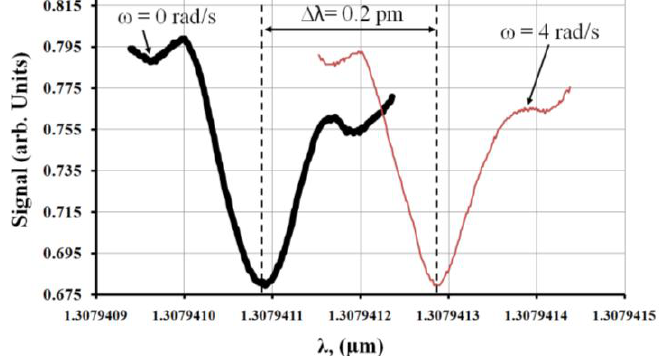
Figure 7. Transmission spectrum of MDR for a (60:1) PDMS